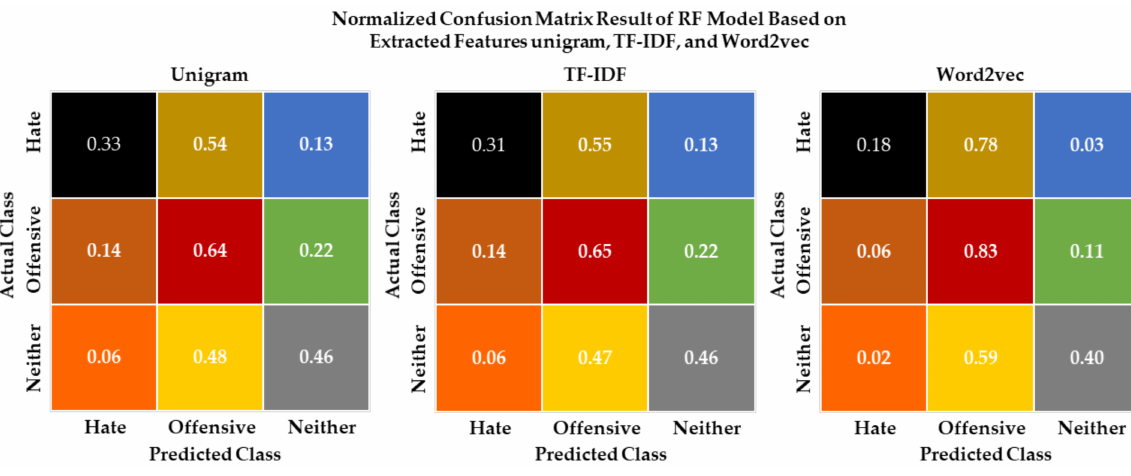
Figure 12. Confusion matrix of sample ternary RF models based on extracted